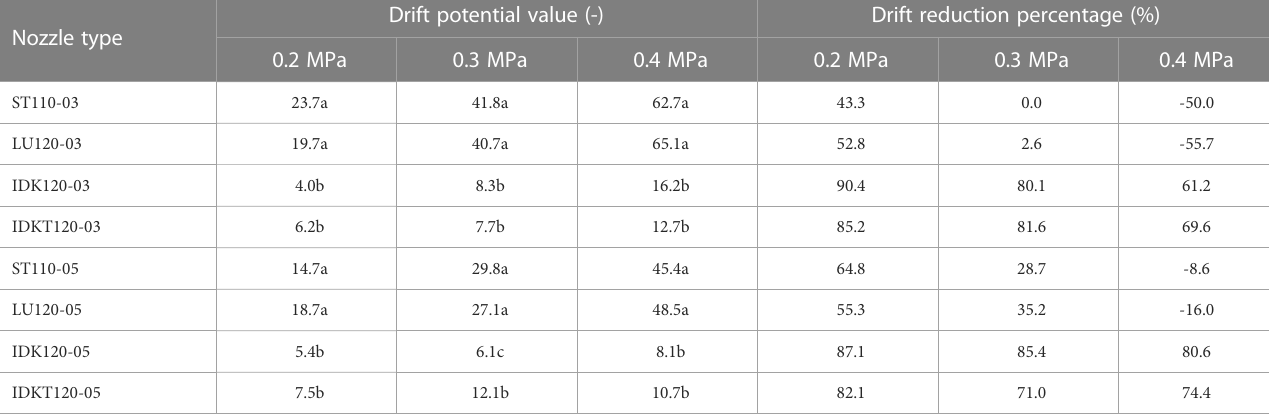
TABLE 5 Drift potential value and drift reduction percentage (%) of the different nozzle – pressure combinations.